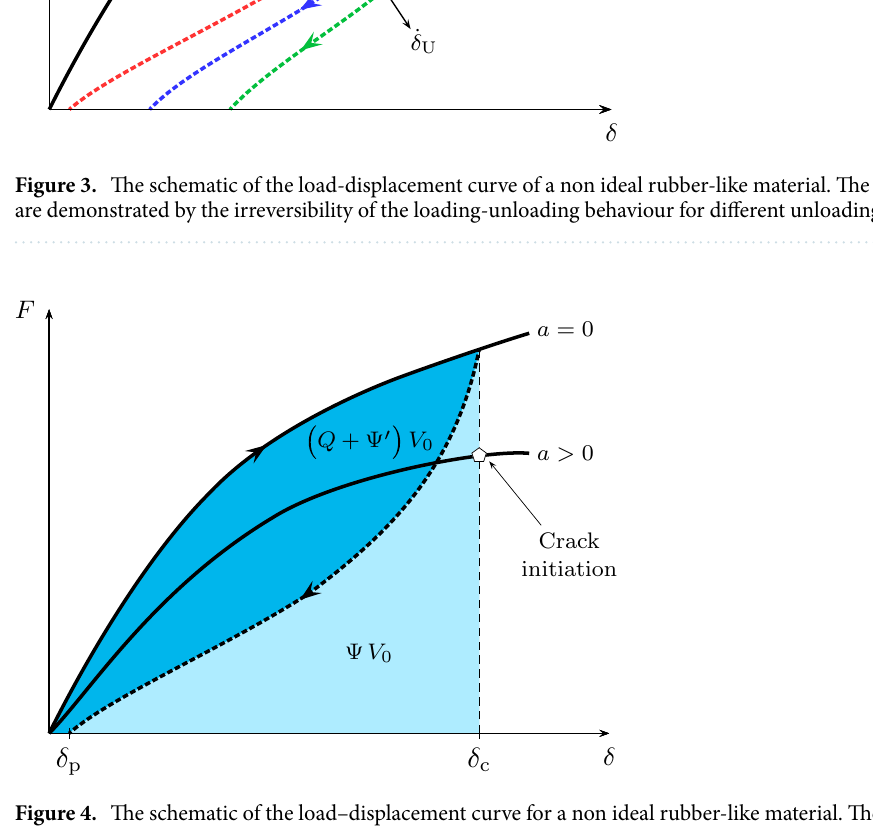
Q + (cid:31) ′ V 0 , in the uncracked specimen at the critical (cid:31) (cid:30)